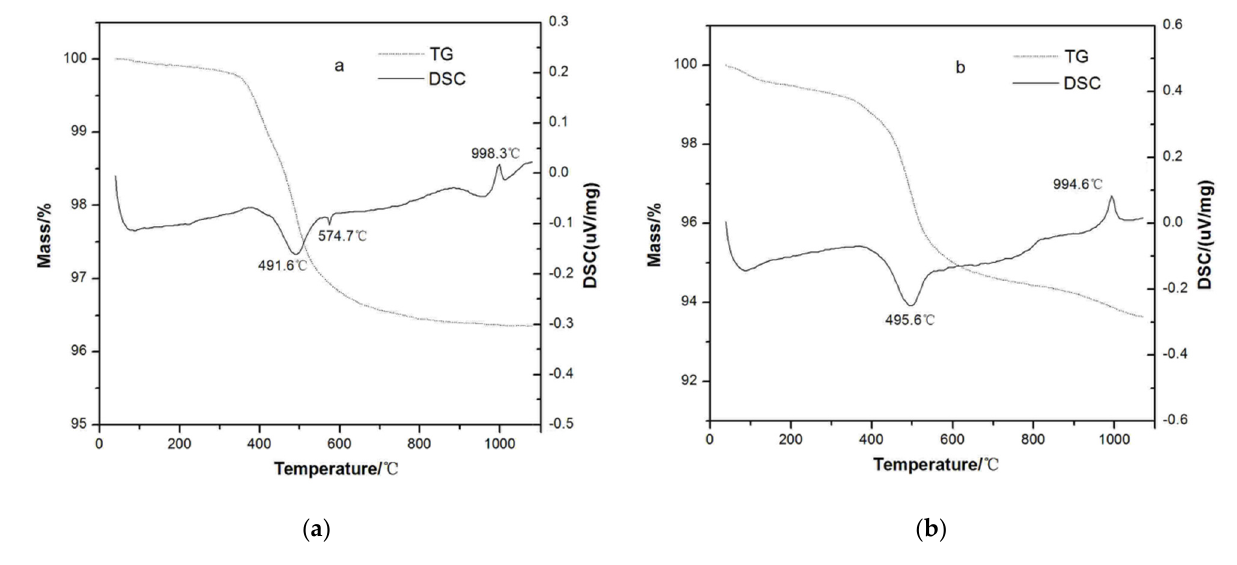
Figure 6. TG − DSC curves of (a) M1 and (b) M2. Table 3. The summary of TG and DSC data of P and PK.